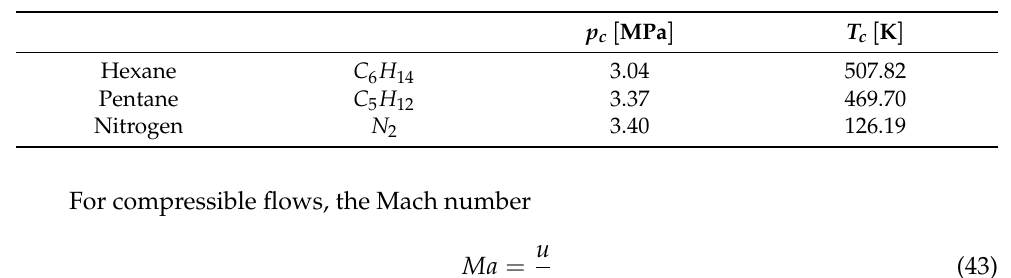
Table 2. Critical properties obtained from Coolprop